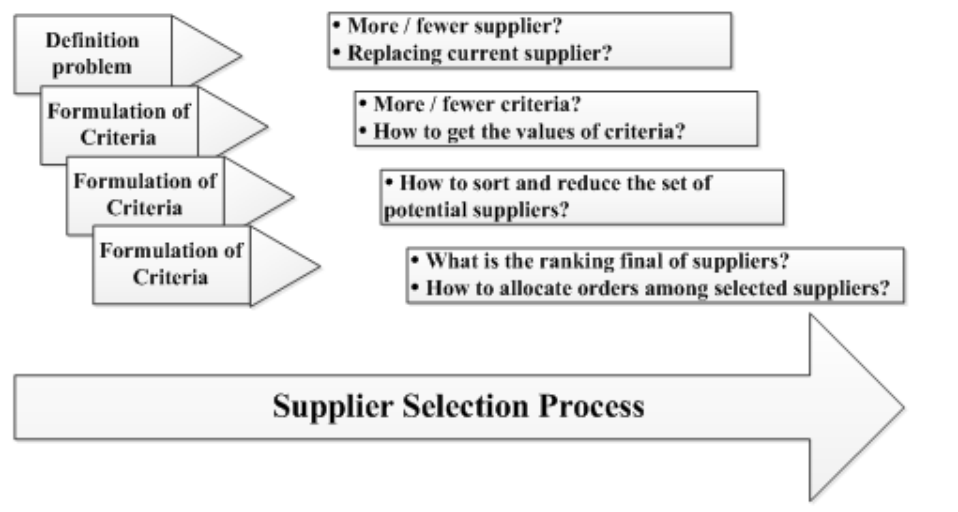
Figure 1. The supplier selection